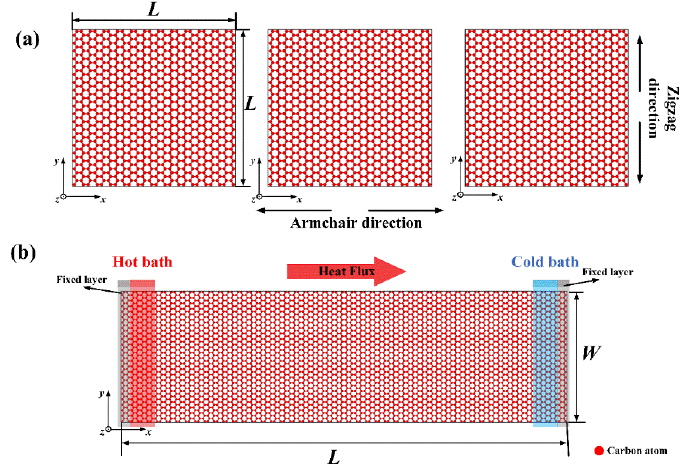
Figure 1. Molecular model of: ( a ) the armchair and zigzag Gr for uniaxial tensile test; and ( b ) Gr for the calculating TC.